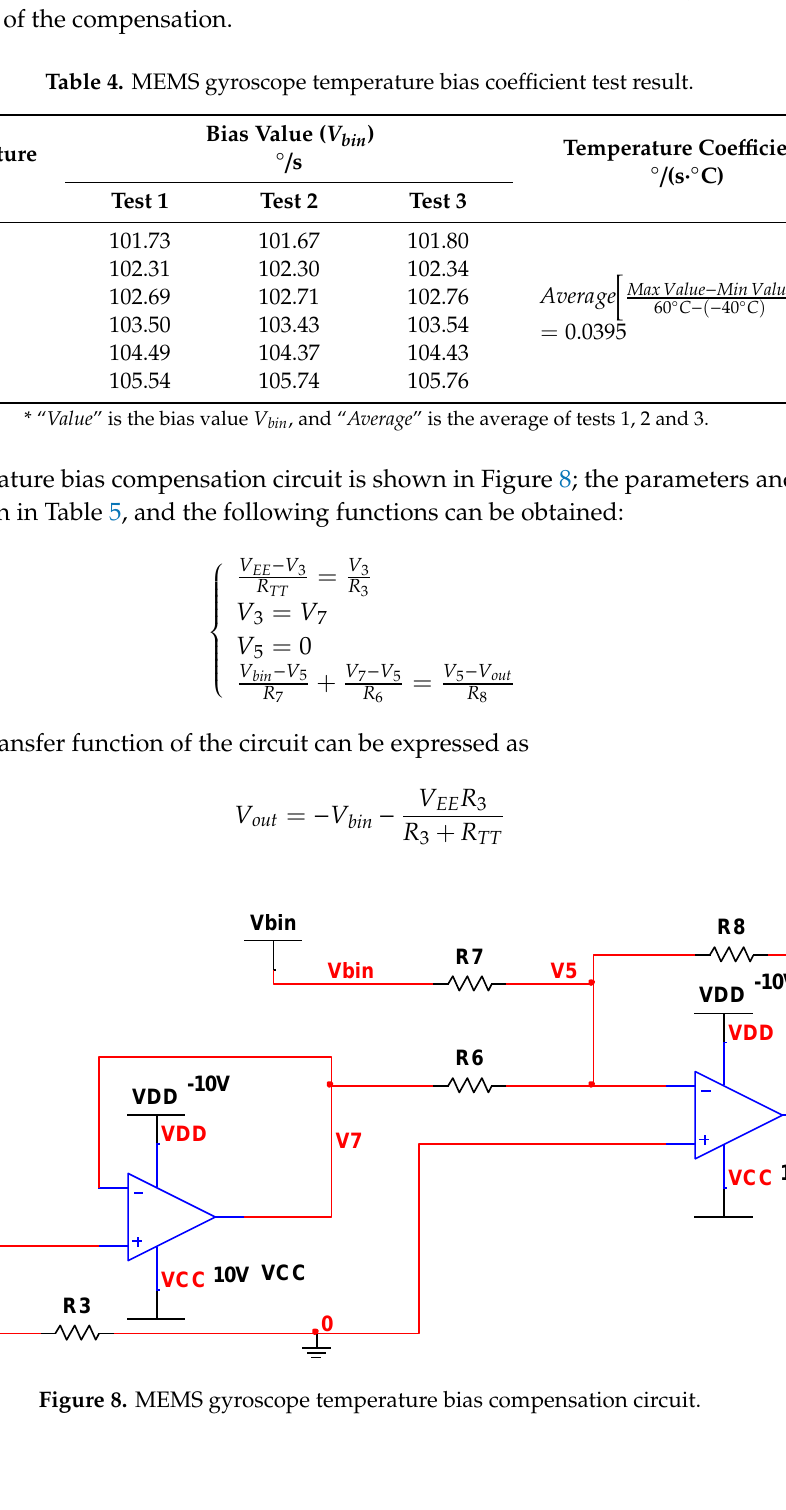
Table 5. MEMS gyroscope temperature bias compensation circuit parameters.